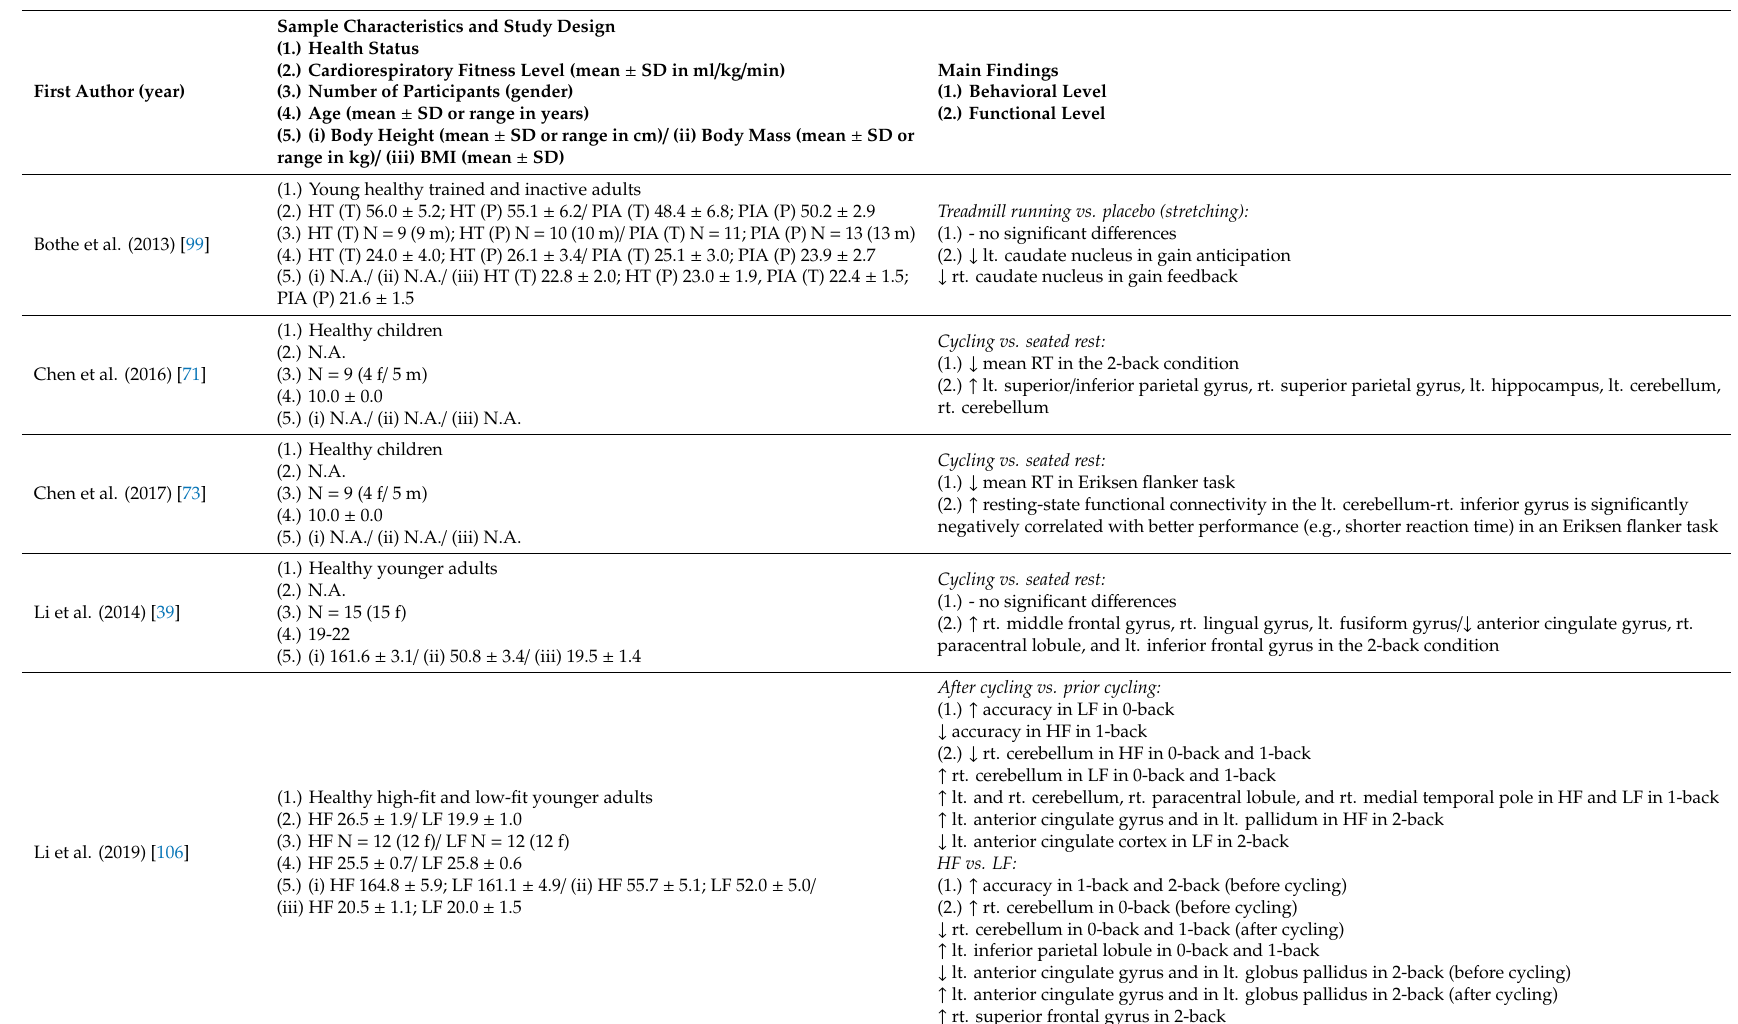
Table 1. Overview of the selected population characteristics and main findings of the reviewed